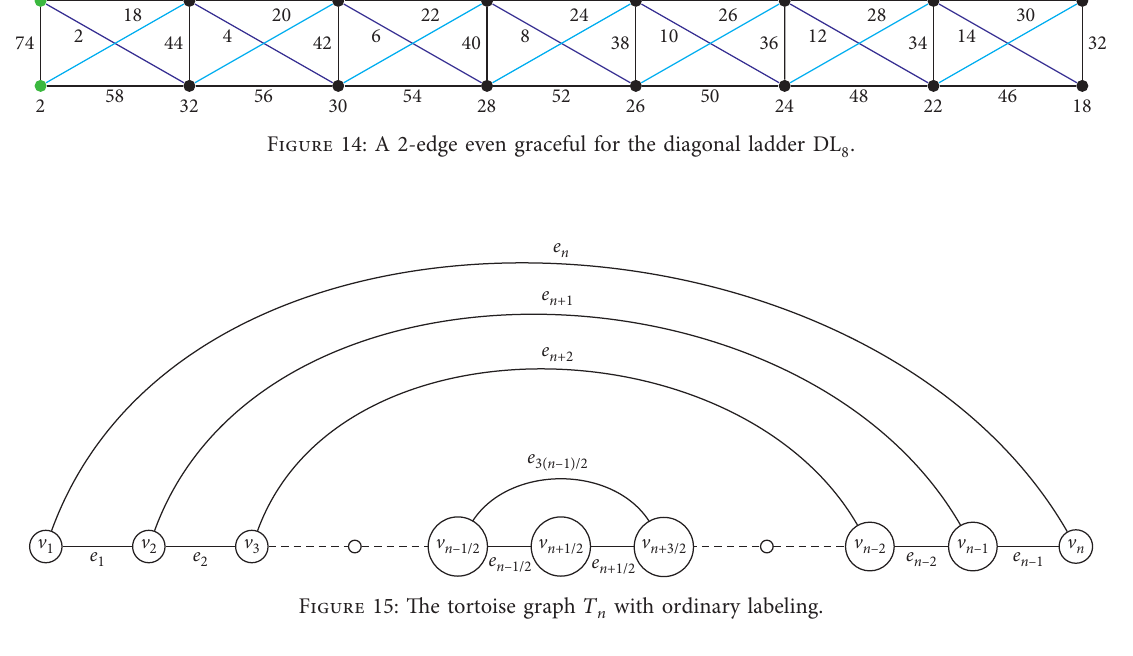
n with ordinary labeling.